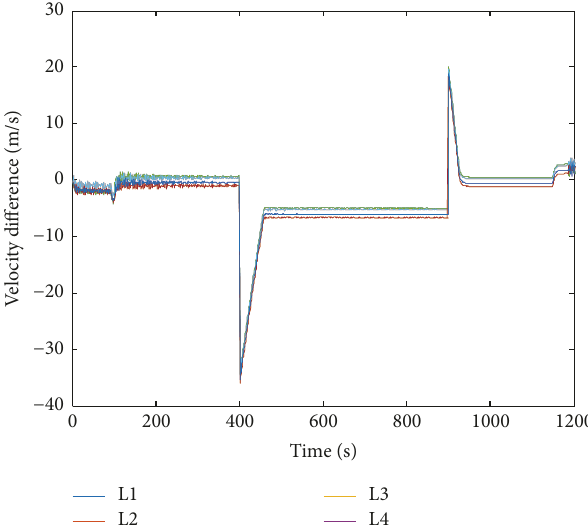
Figure 14: The velocity of each vehicle under MPC method with external stochastic